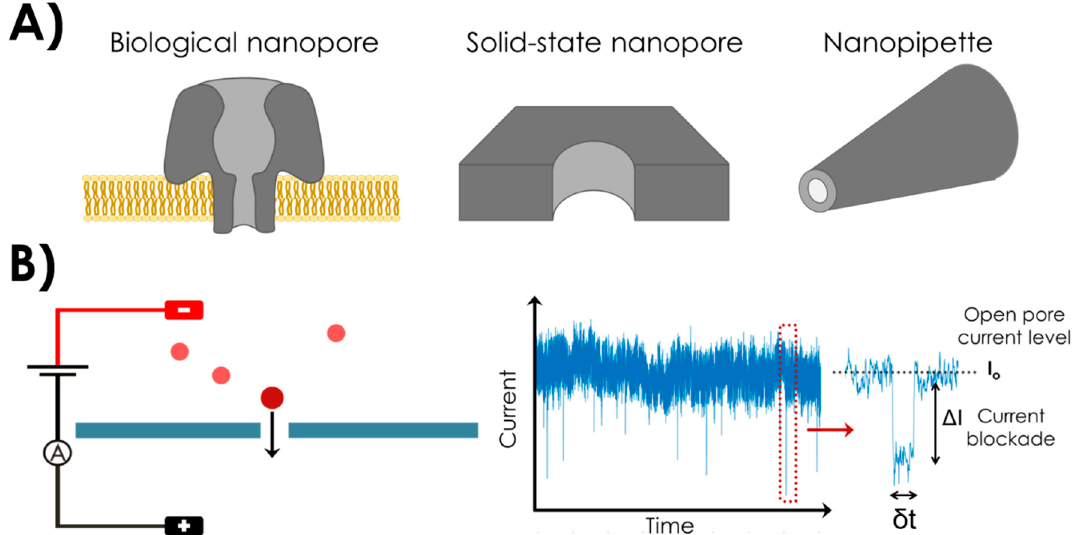
Figure 1. ( A ) Illustration of a biological nanopore in a lipid bilayer (left) a solid-state nanopore fabricated in an insulating membrane (middle) and a nanopipette (right). ( B ) Solid-state nanopore principle. A dielectric membrane separates two electrolytes reservoirs connected solely through the nanopore. Electrodes are placed at each side of the membrane and a voltage is applied. Measured ionic current results from the electrolyte charges moving through the nanopore.